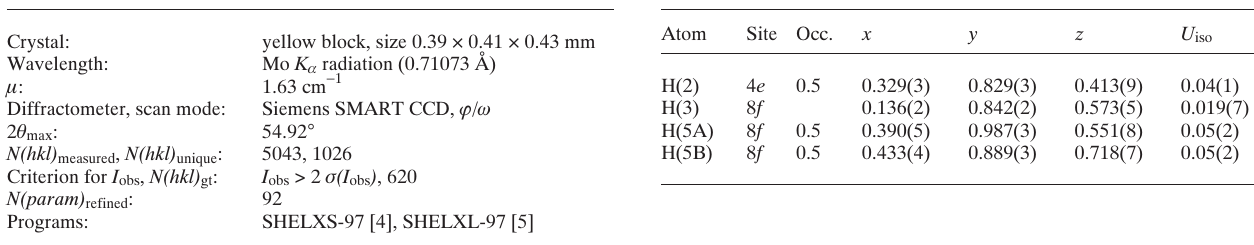
Table 2. Atomic coordinates and displacement parameters (in Å 2 ) . Table 1. Datacollection and